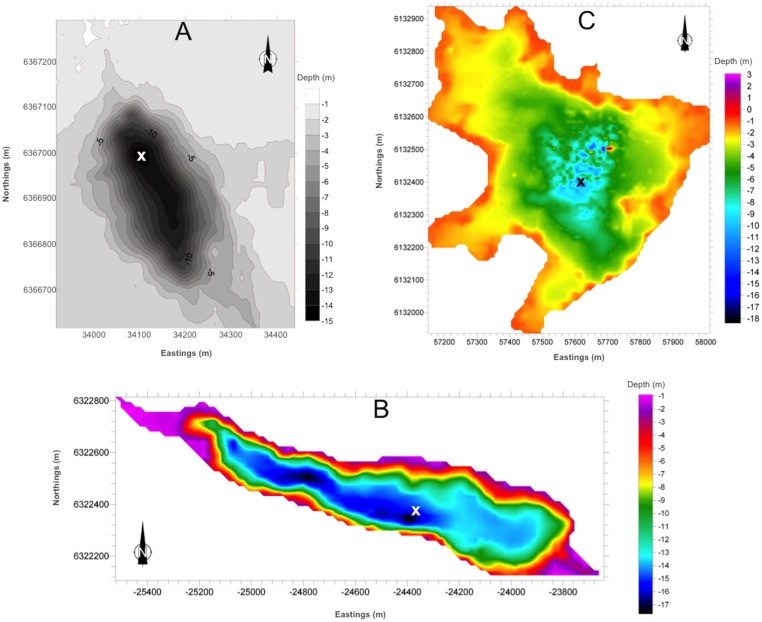
Hydrographic Charts of (A) Loch Coire nan Arr, (B) Loch Doilet and (C) Loch Urr.The hydrographic survey was completed with a MIDAS Surveyor GPS Echosounder supplied with a 210kHz transducer (Valeport, Devon, UK) at the beginning of this study. Approximate depth is shown in metres and a change in depth is indicated by the grey/colour scale. The X denotes where the sampling took place.